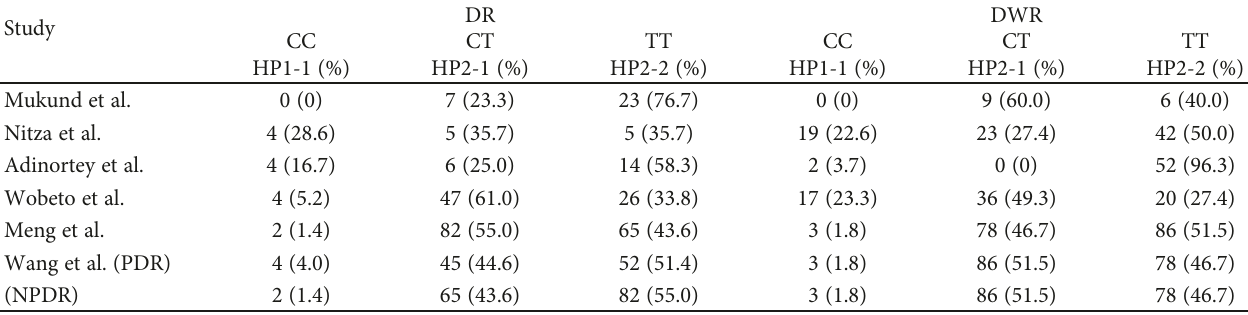
Table 2: Hp allele frequencies of cases and controls.